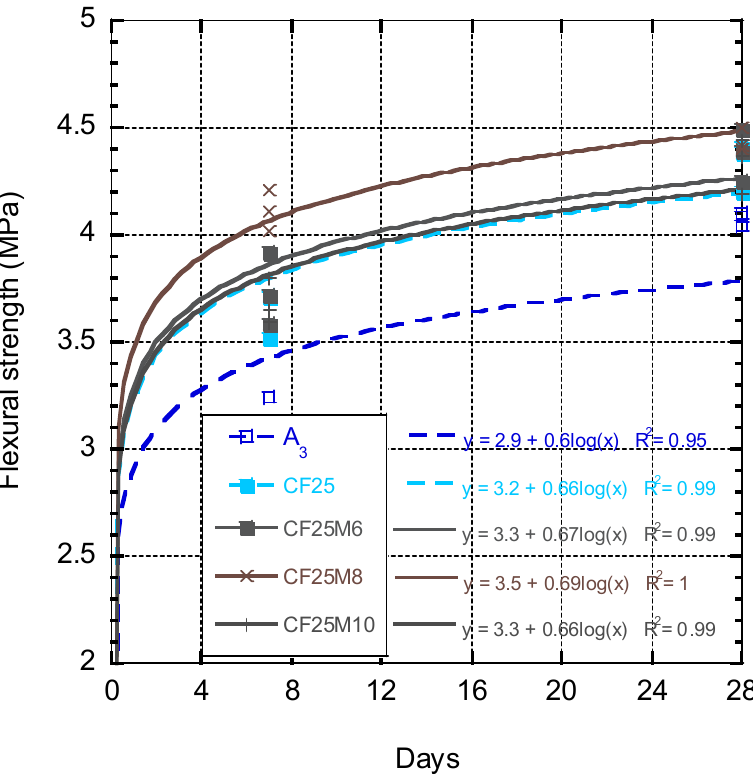
Figure 13. Flexural strength of concrete (D) with different percentages of micro - silica. Figure 14. Flexural strength of concrete (D) with different percentages of